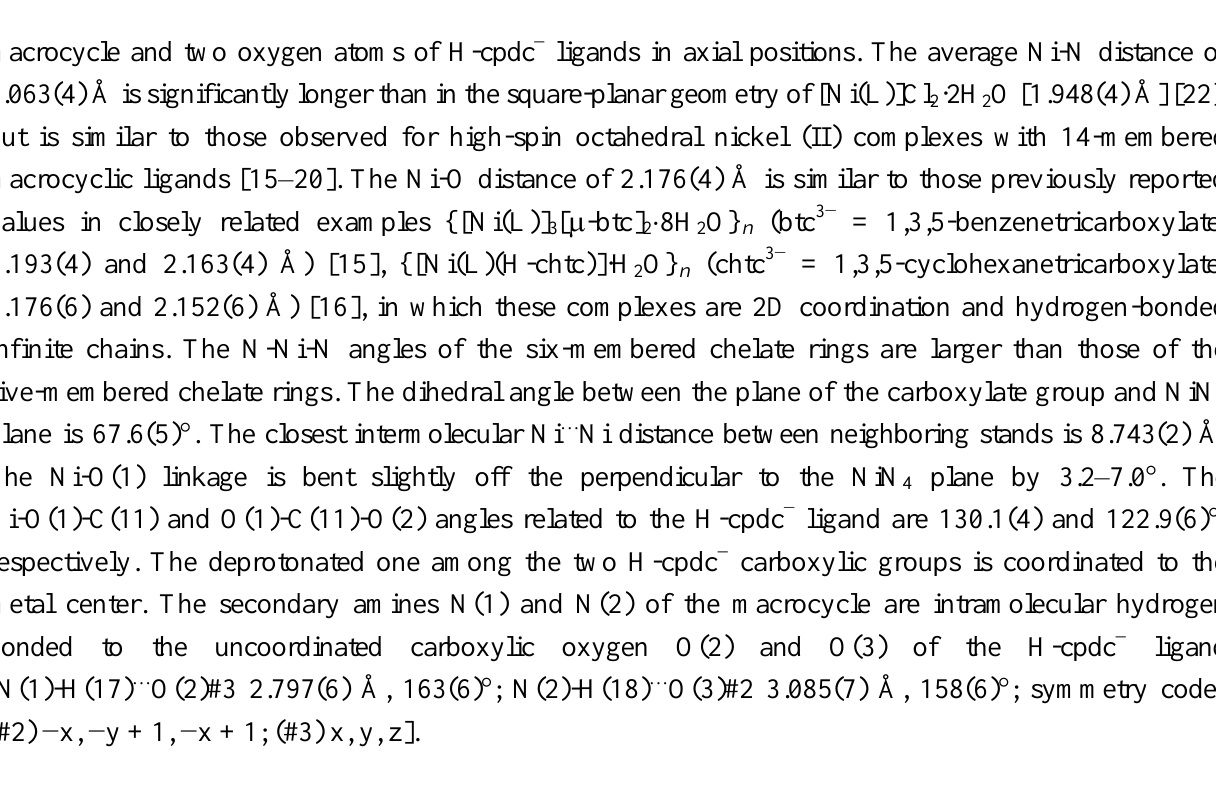
Figure 1. An ORTEP diagram of [Ni(L)(H-cpdc − )